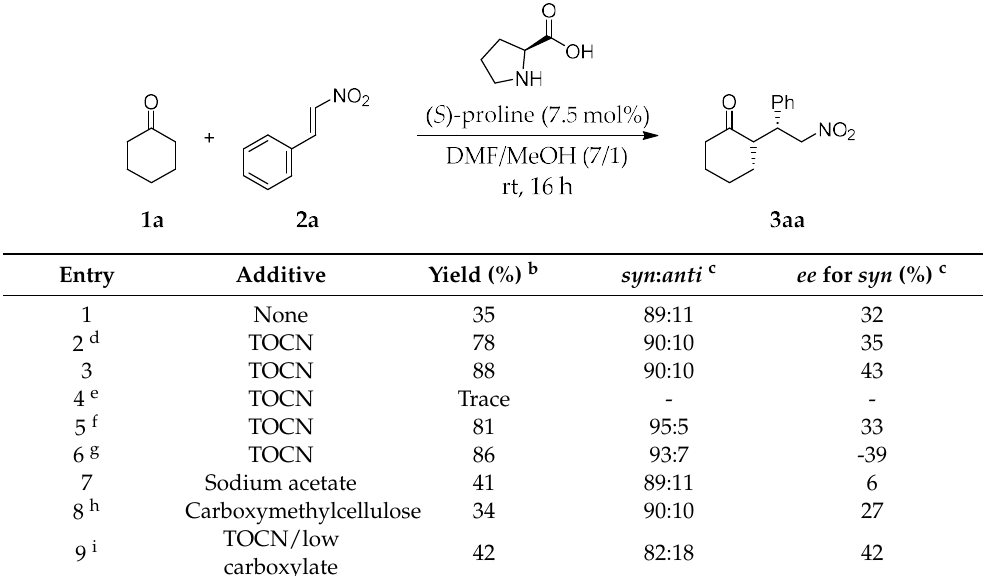
Table 1. Catalytic behavior of proline combined with cellulose nanofibers and additives in the Michael addition a .